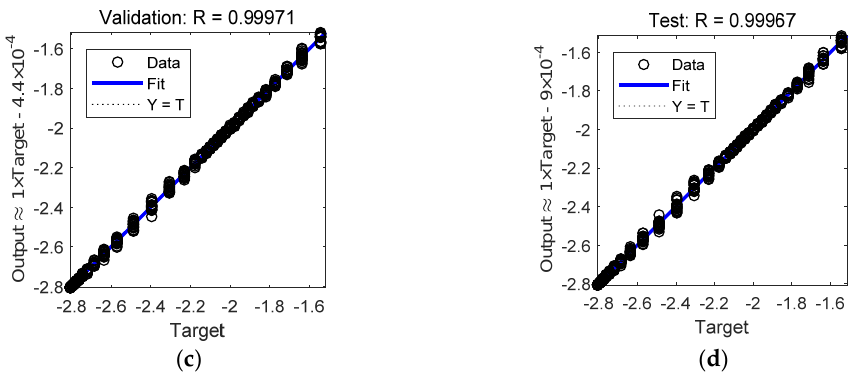
Figure 4. The BP NN training results: ( a ) the training errors of the training set, validation set, and test set; ( b ) regression of the training set; ( c ) regression of the validation set; ( d ) regression of the test set.